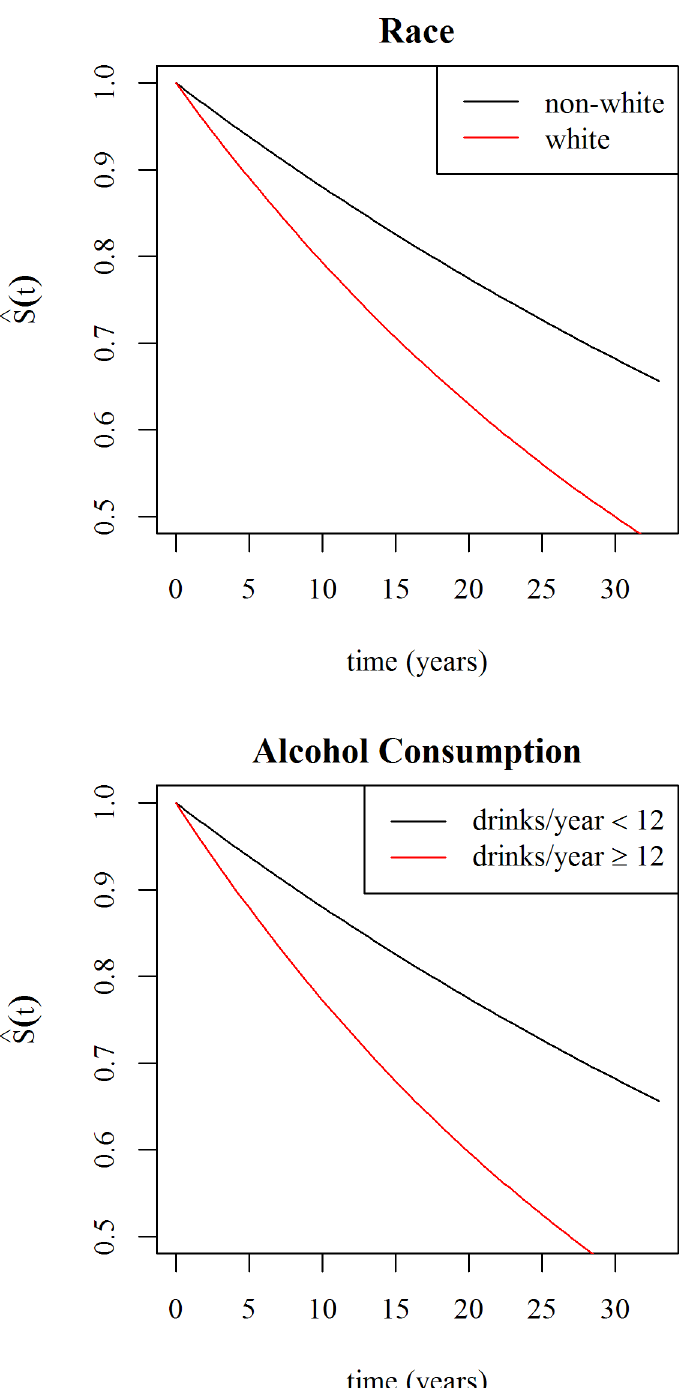
Fig 2. Survival curves for duration of hot flashes in perimenopausal US women by race (top) and alcohol consumption (bottom). Survival at time t, S(t), is defined as still experiencing hot flashes t years after their onset. Race was divided into white (red line) and non-white (black line). Alcohol consumption was divided into < 12 drinks in the last year (black line) and at least 12 drinks in the last year (red line).